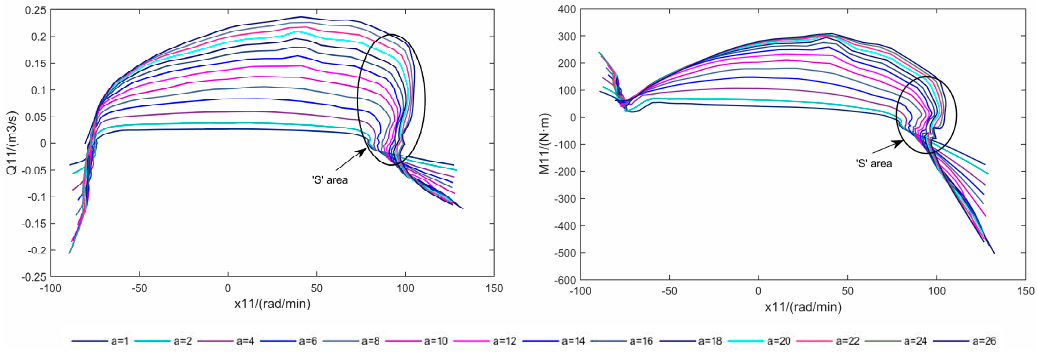
Figure 4. The characteristic pump-turbine curves.